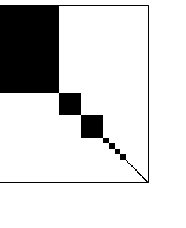
,..., B G , C , D , E } , and E × Z for Z ∈ B ∗ ∗ ∗ ∗ M 1